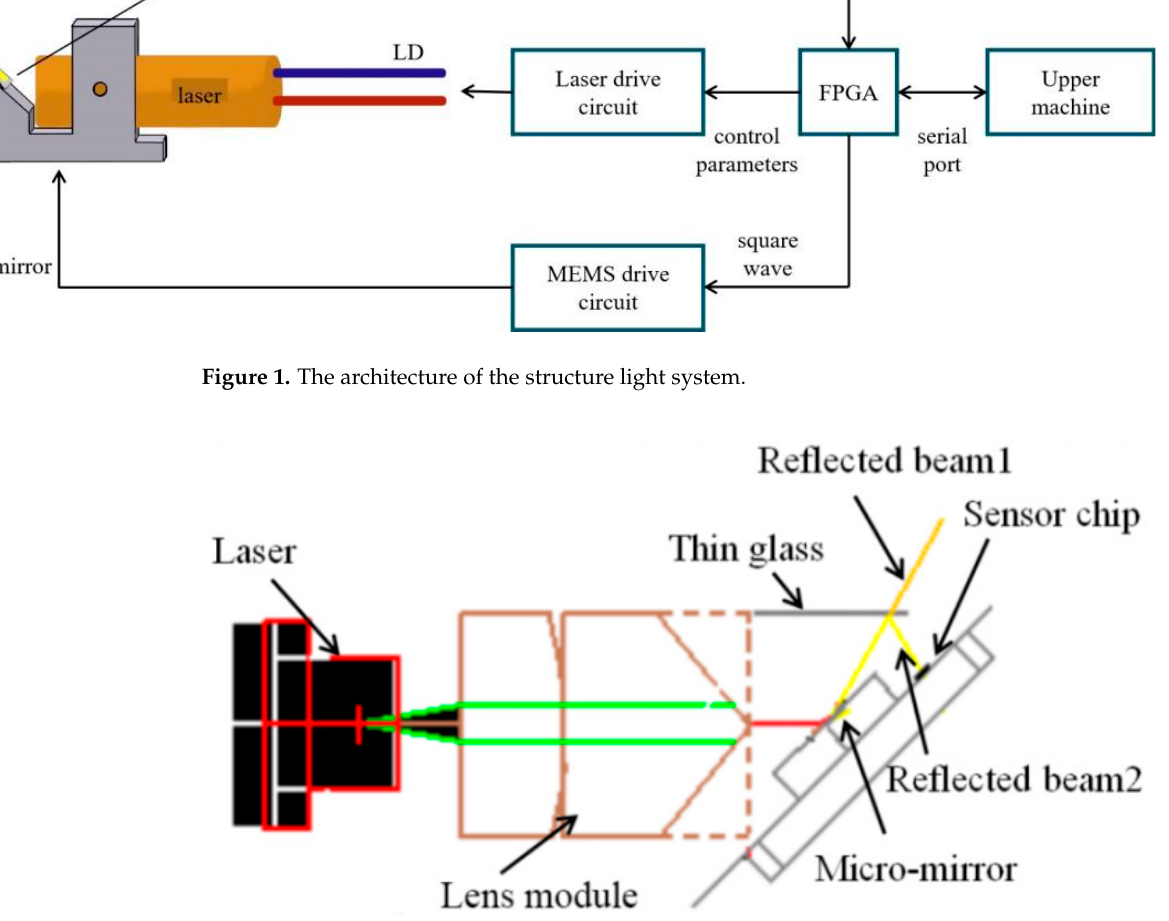
Figure 2. The structure of the micromirror-based projection system.